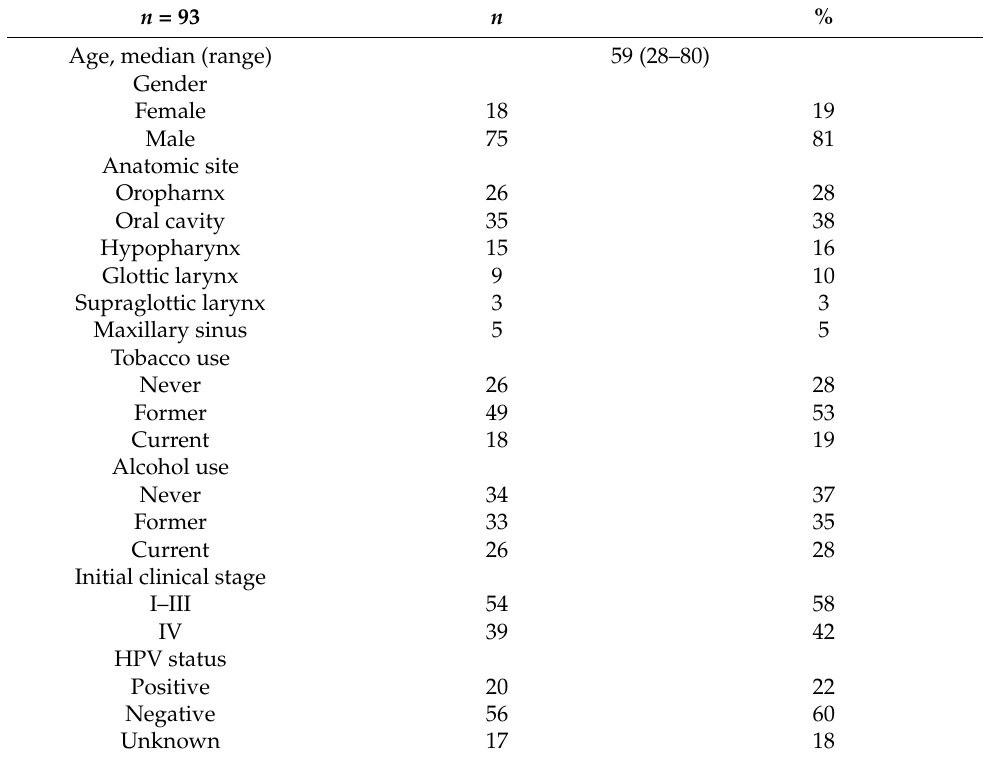
Table 1. Baseline characteristics in all